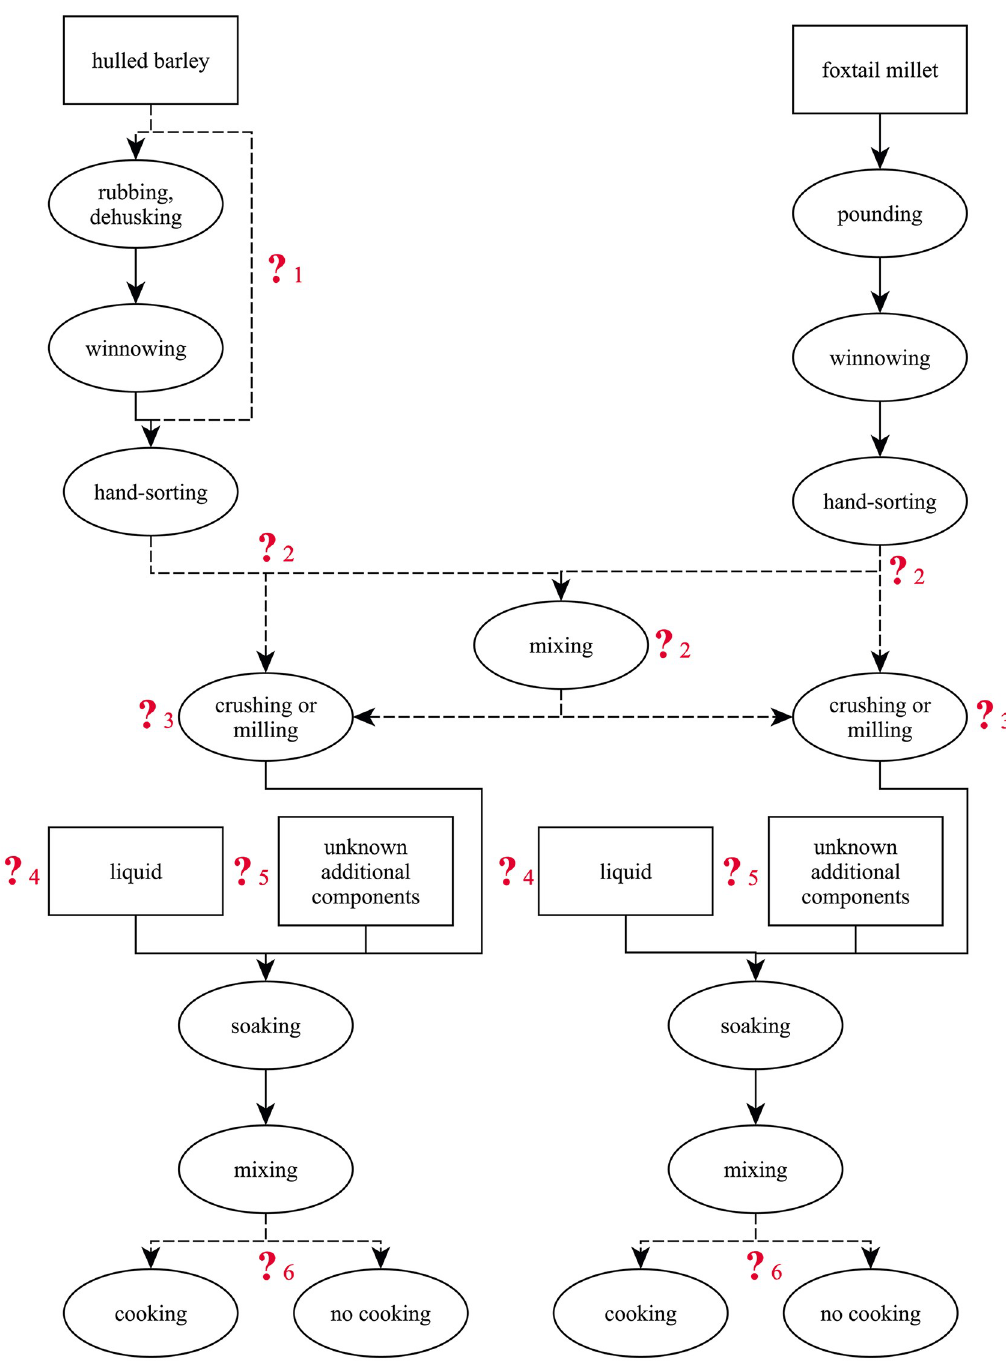
Fig 22. Model for the chaîne opératoire of the charred cereal products found at Prigglitz-Gasteil. Rectangles: components, ovals: processes. Dashed lines indicate ramifications, i. e. options/choices in processes. Numbered question marks indicate uncertainties: 1 ... the observed barley glumes can derive from entirely dehulled grains used “as is” or be mere remainders in intentionally dehulled barley, 2 ... the two cereal species were processed together or separately, 3 ... the grains were either finely ground, or just coarsely crushed, 4 ... water and/or other liquid was used for soaking; 5 ... other ingredients were possibly used, 6 ... the mushy cereal preparation was intended to be eaten either raw or cooked. Diagram: OeAW-OeAI/A. G. Heiss.